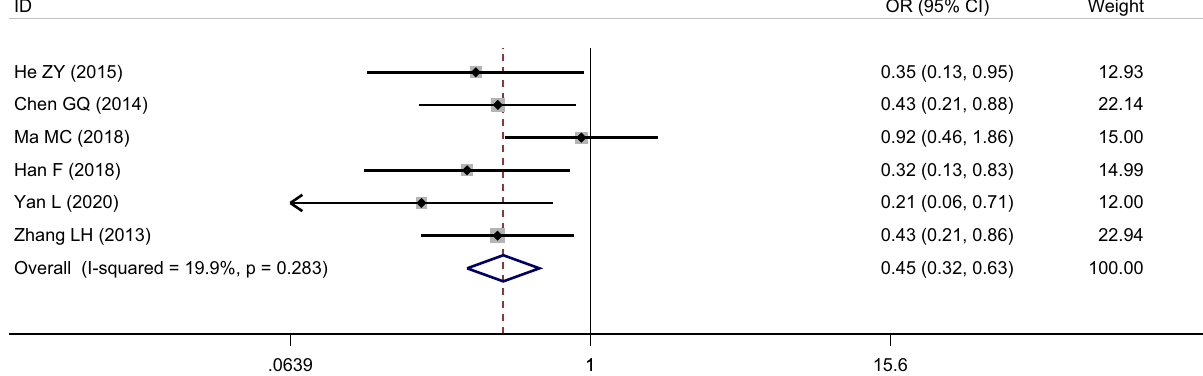
0.283)Zhang Overall (I-squared = 19.9%, p =